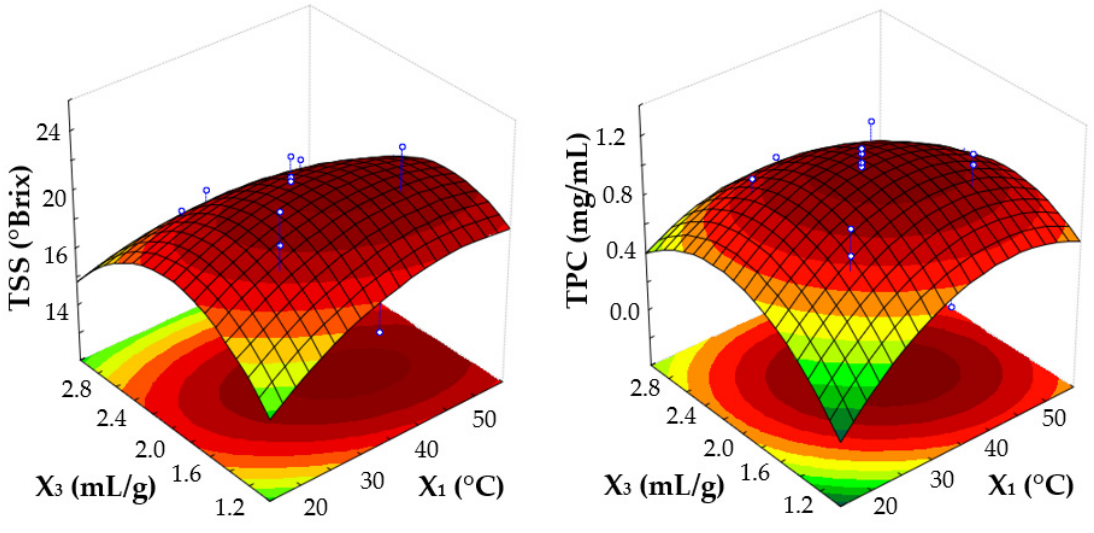
Figure 3. Response surface plots showing the effects of liquid–solid ratio (X 3 ) vs. temperature (X 1 ) on TSS and TPC in UAE carob syrup.